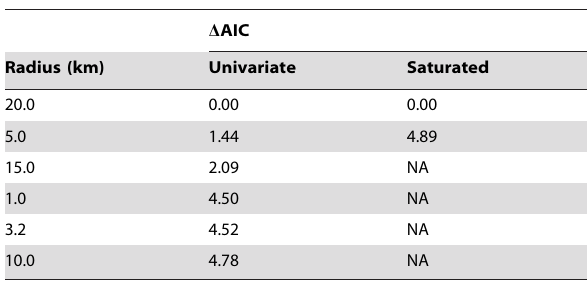
Table 1. D AIC values from univariate and saturated models used to determine the best fit radius from a lek within which to measure the density of oil and gas